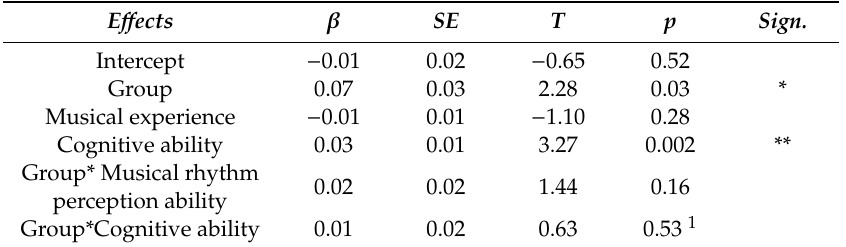
Table A4. Parameters of the regression analysis of the e ff ects of dyslexia, musical experience and cognitive ability on musical rhythm perception